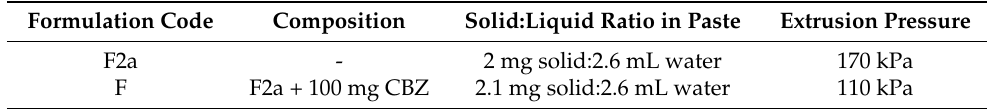
Table 11. Differences in preparation and fabrication via SSE of F and F2a.